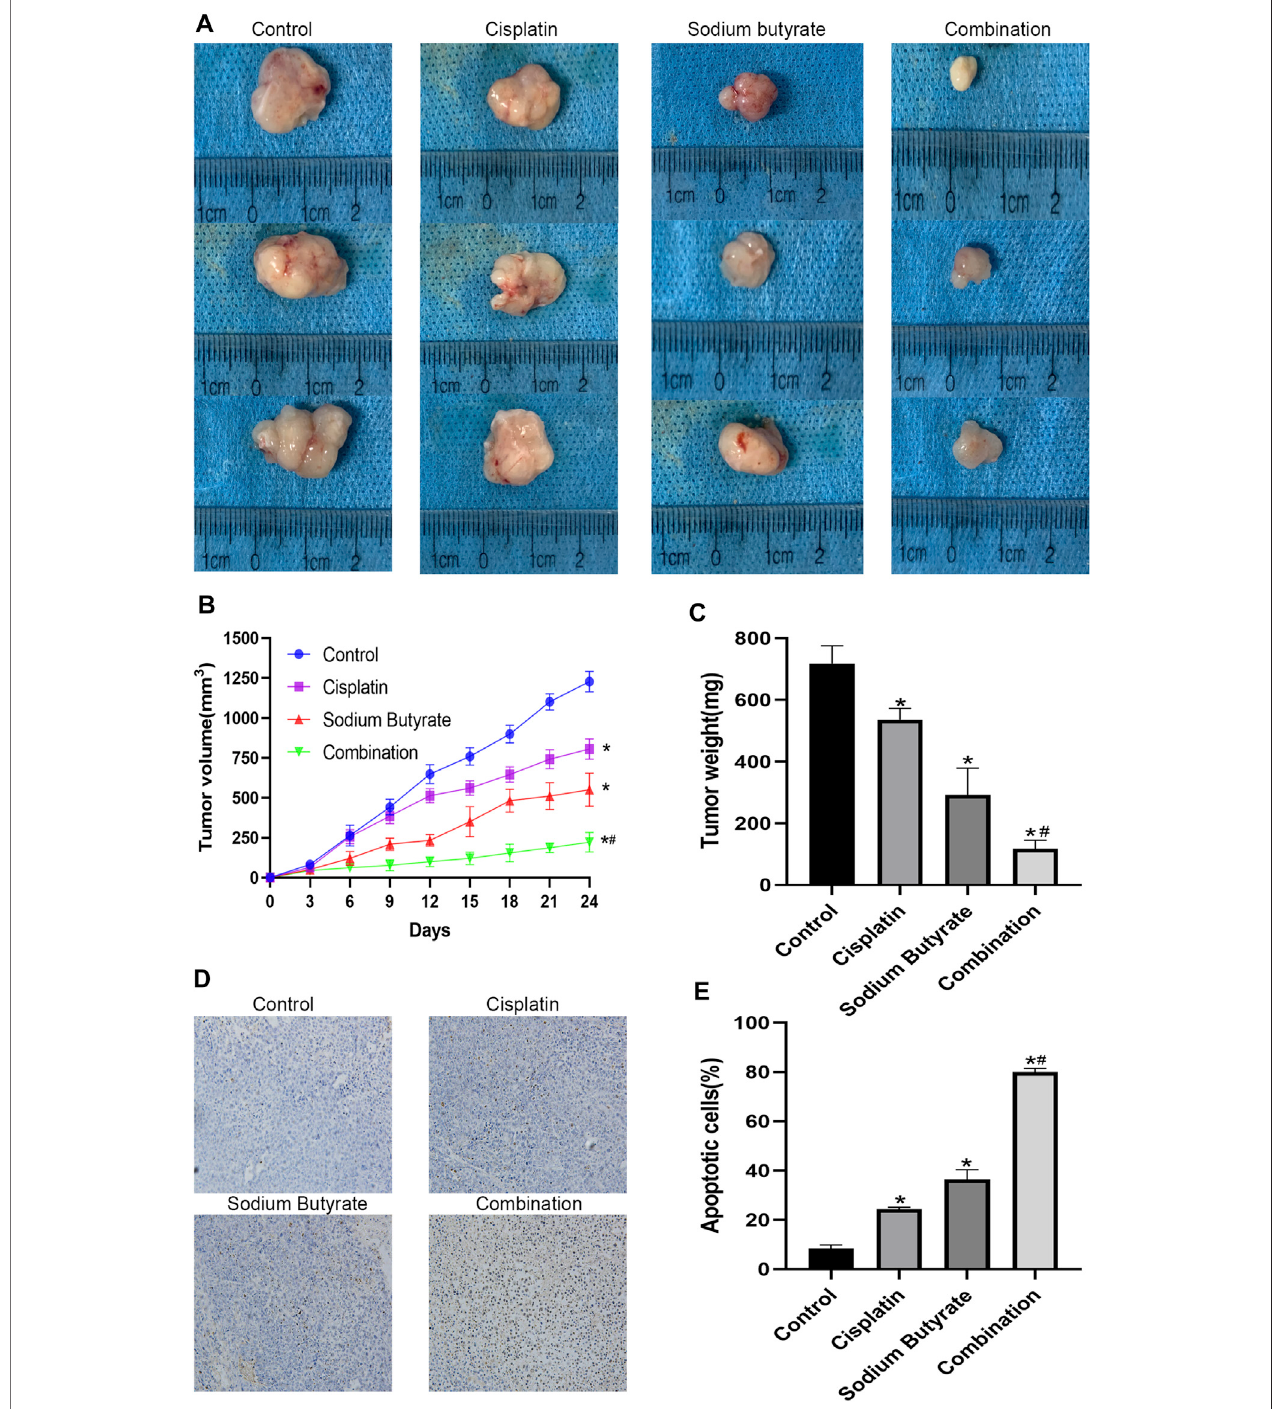
FIGURE8| Anti-tumoreffects ofcisplatin andsodium butyrate invivo . (A) Morphologyofthesubcutaneousimplanted tumor. (B) Meantumor volumeateach time point. (C) The tumor weight obtained at the end of the experiment. (D) A TUNEL assay was performed to detect the apoptotic cells in the tumor tissue. (E) Quantitative analysis of the apoptosis rate in (D) . * p < 0.05 vs the control; *# p < 0.05 vs cisplatin alone. All the above data are the mean ± SD from an average of three experiments.